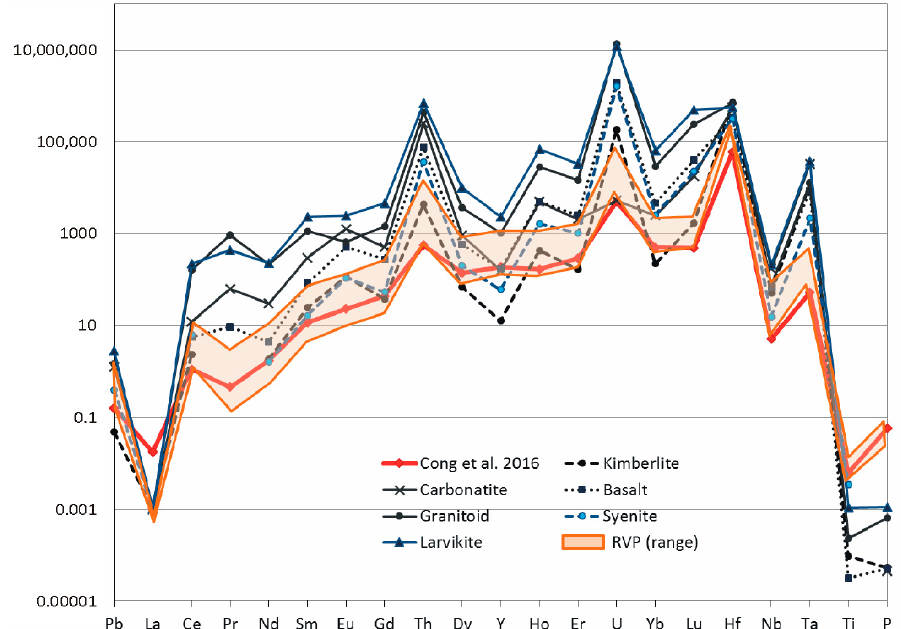
Figure 10. Chondrite-normalized trace element spidergram for zircon from the RVP (orange shaded region) including average data from Cong et al. (red [23]) and zircon from other rock types [5] .